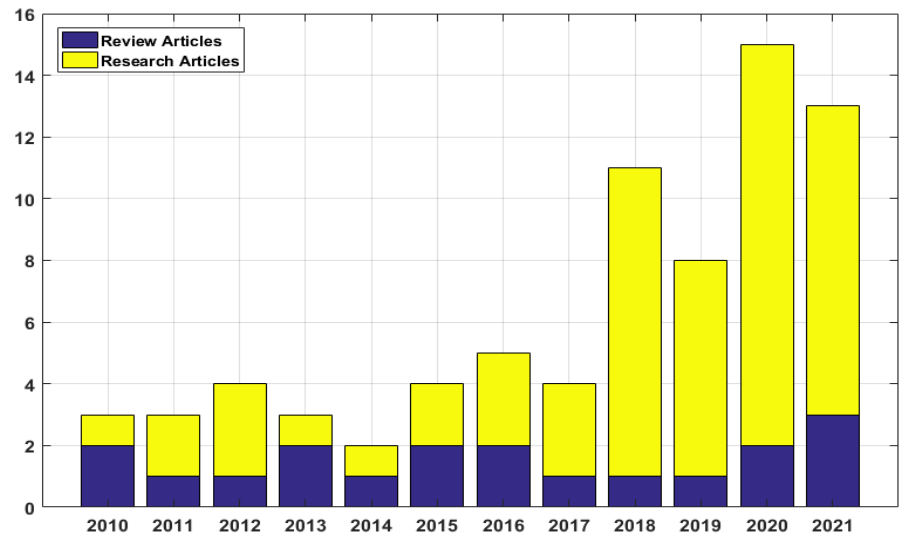
Figure 2. Number of selected research articles and review articles per year from 2010 to 2021.